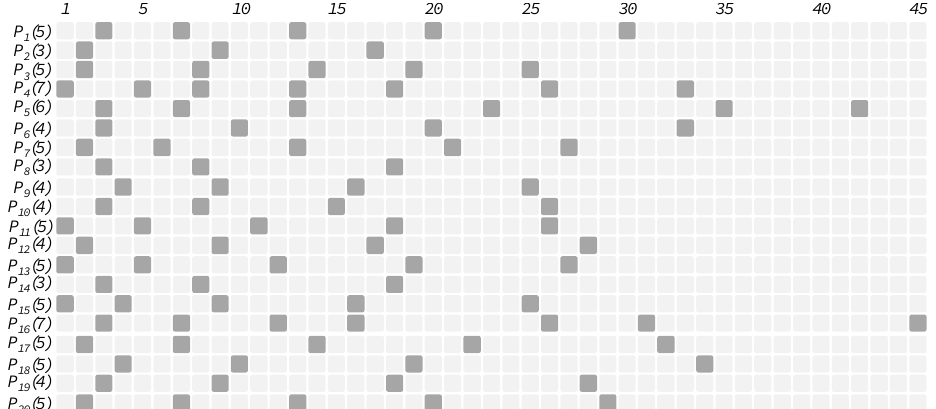
Figure 13. Number and time of PC retrainings for each participant.